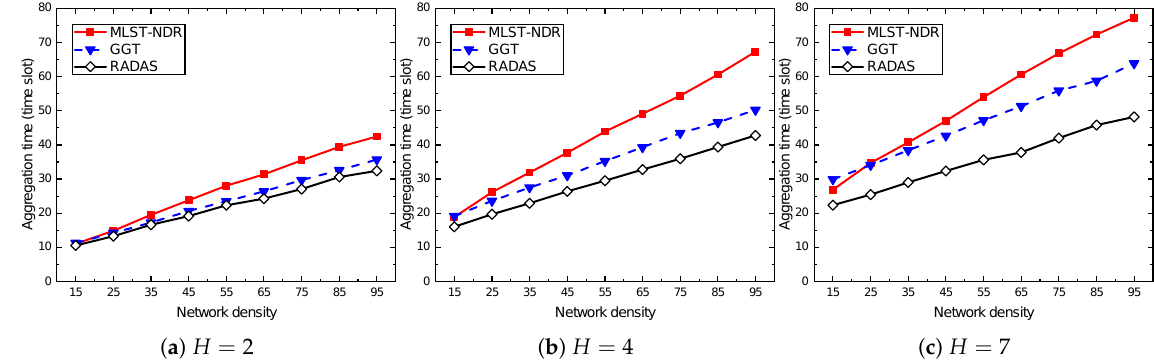
Figure 10. Aggregation time comparison when network density